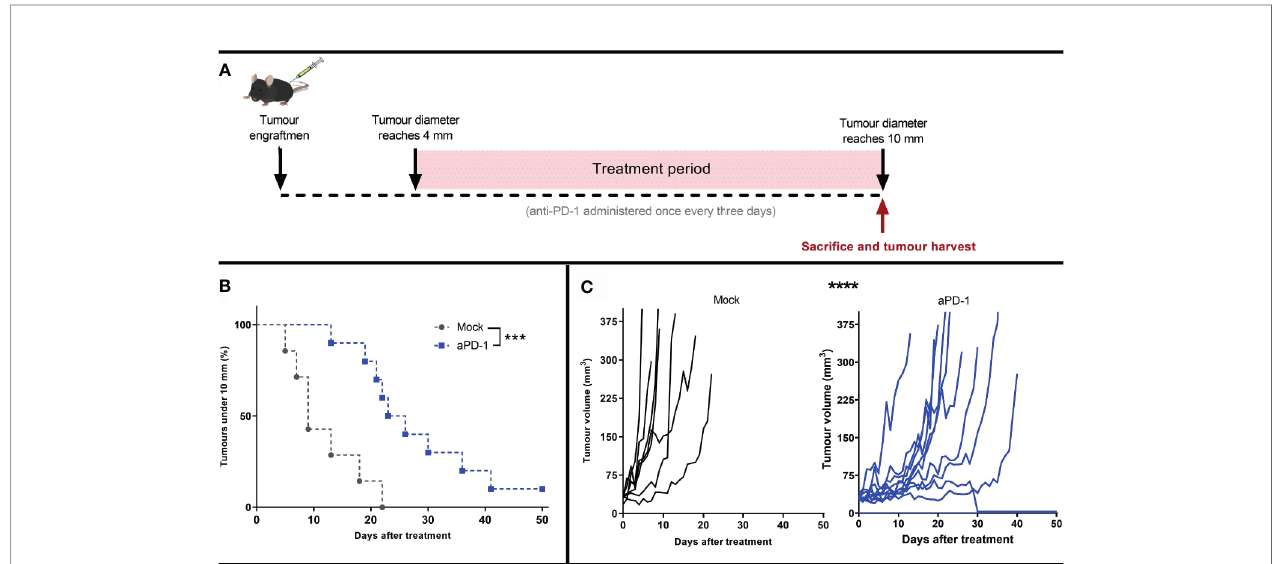
FIGURE 1 | Development of an in vivo model refractory to aPD-1. (A) Experimental design: 17 mice were engrafted with subcutaneous B16.OVA tumors (2.5 x 10 5 cells/animal). When those tumors reached 4 mm in maximum diameter, the animals were assigned to Mock (n=7) or to aPD-1 group (n=10). 0.1 mg of aPD-1 (or PBS) was given intraperitoneally every three days. When tumors progressed over 10 mm, animals were sacri fi ced. (B) Percentage of animals with a tumor under 10 mm after they started treatment. (C) Individual tumor growth curves for both groups. (Kaplan-Meier, Log rank Mantel-Cox test; ***p < 0.001, ****p <